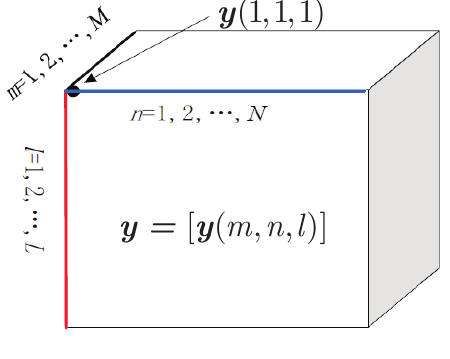
Figure 2. The tensor diagram of received